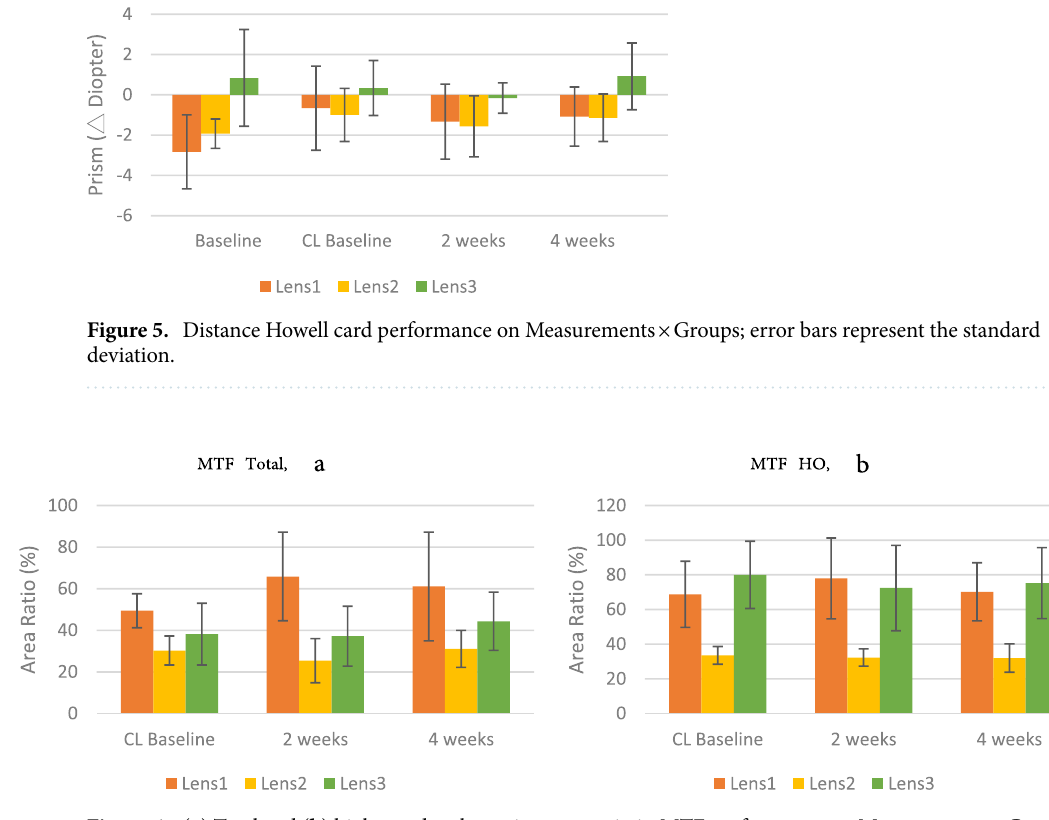
Figure 6. ( a ) Total and ( b ) higher order aberration area ratio in MTF performance on Measurements × Groups; error bars represent the standard